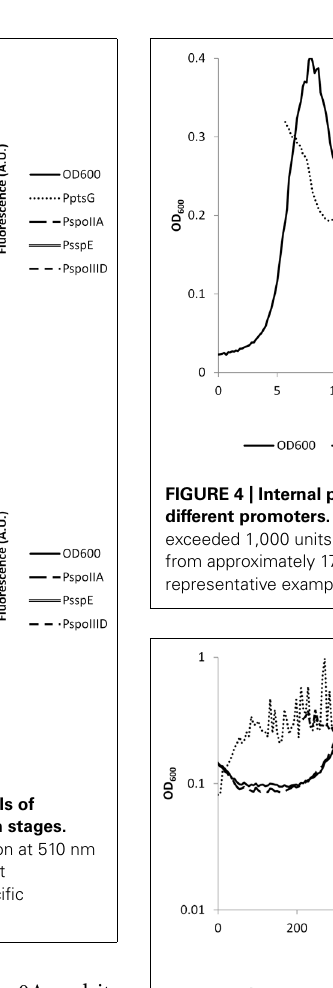
FIGURE 5 | Internal pH during spore germination and outgrowth. IpHluorin accumulated in the spores (from expression controlled by P sspE ) allows pH measurements from t = 0 to approximately 300 min. Expression of IpHluorin from P ptsG allows calculation of the pHi from approximately 200 min. Data are from a representative example of germination and outgrowth of B. subtilis spores at an external pH of